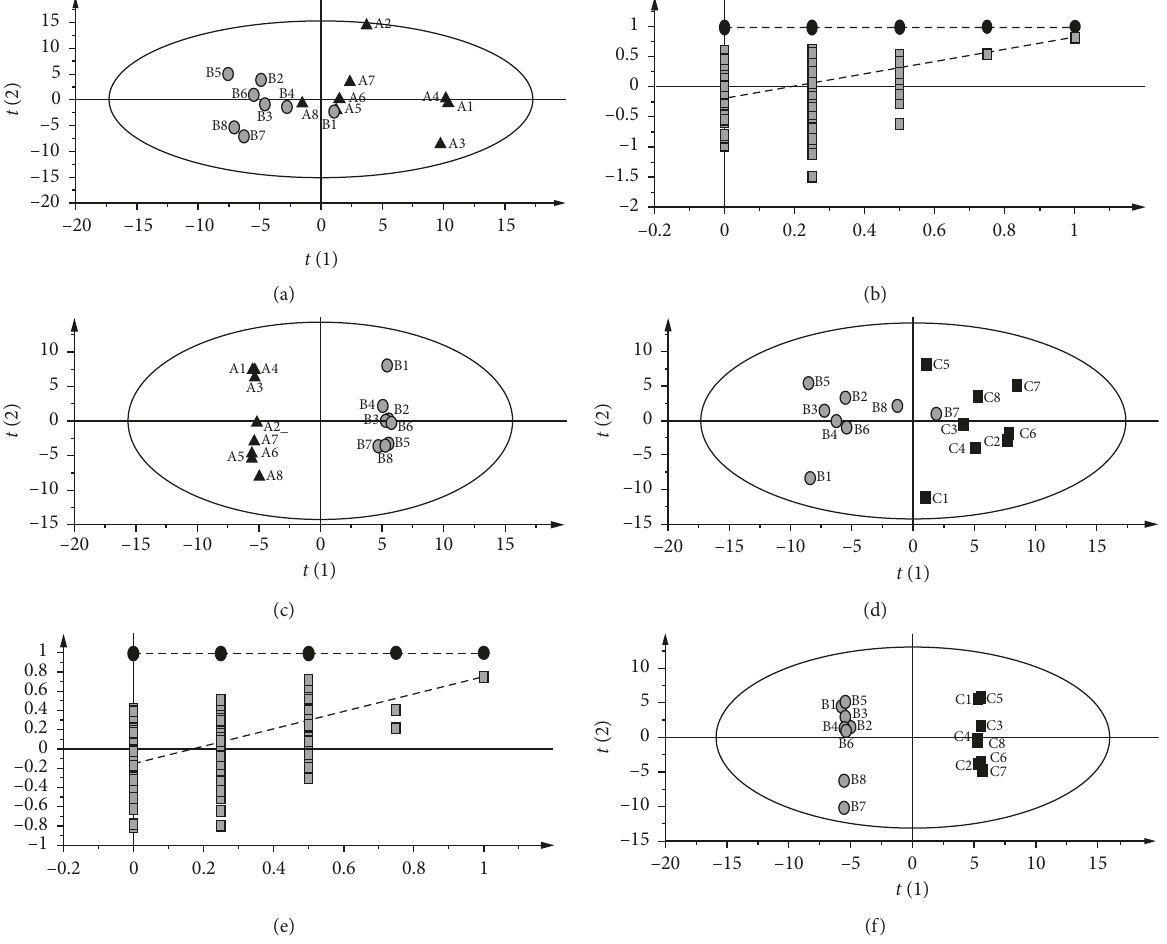
Figure 1: PCA, corresponding validation plots of OPLS-DA, and OPLS-DA score plots derived from the GC × GC-TOF/MS between day 0 and day 4 and day 4 and day 8 during chilled ageing. Day 0: triangles; day 4: circles; day 8: